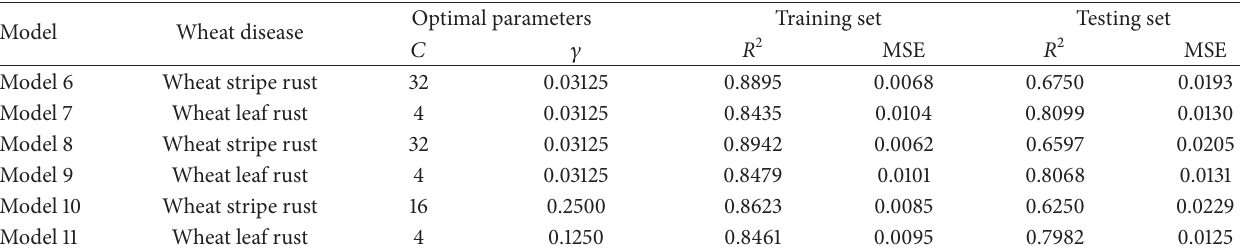
Table 4: The results of disease index inversion SVR models of wheat stripe rust and wheat leaf